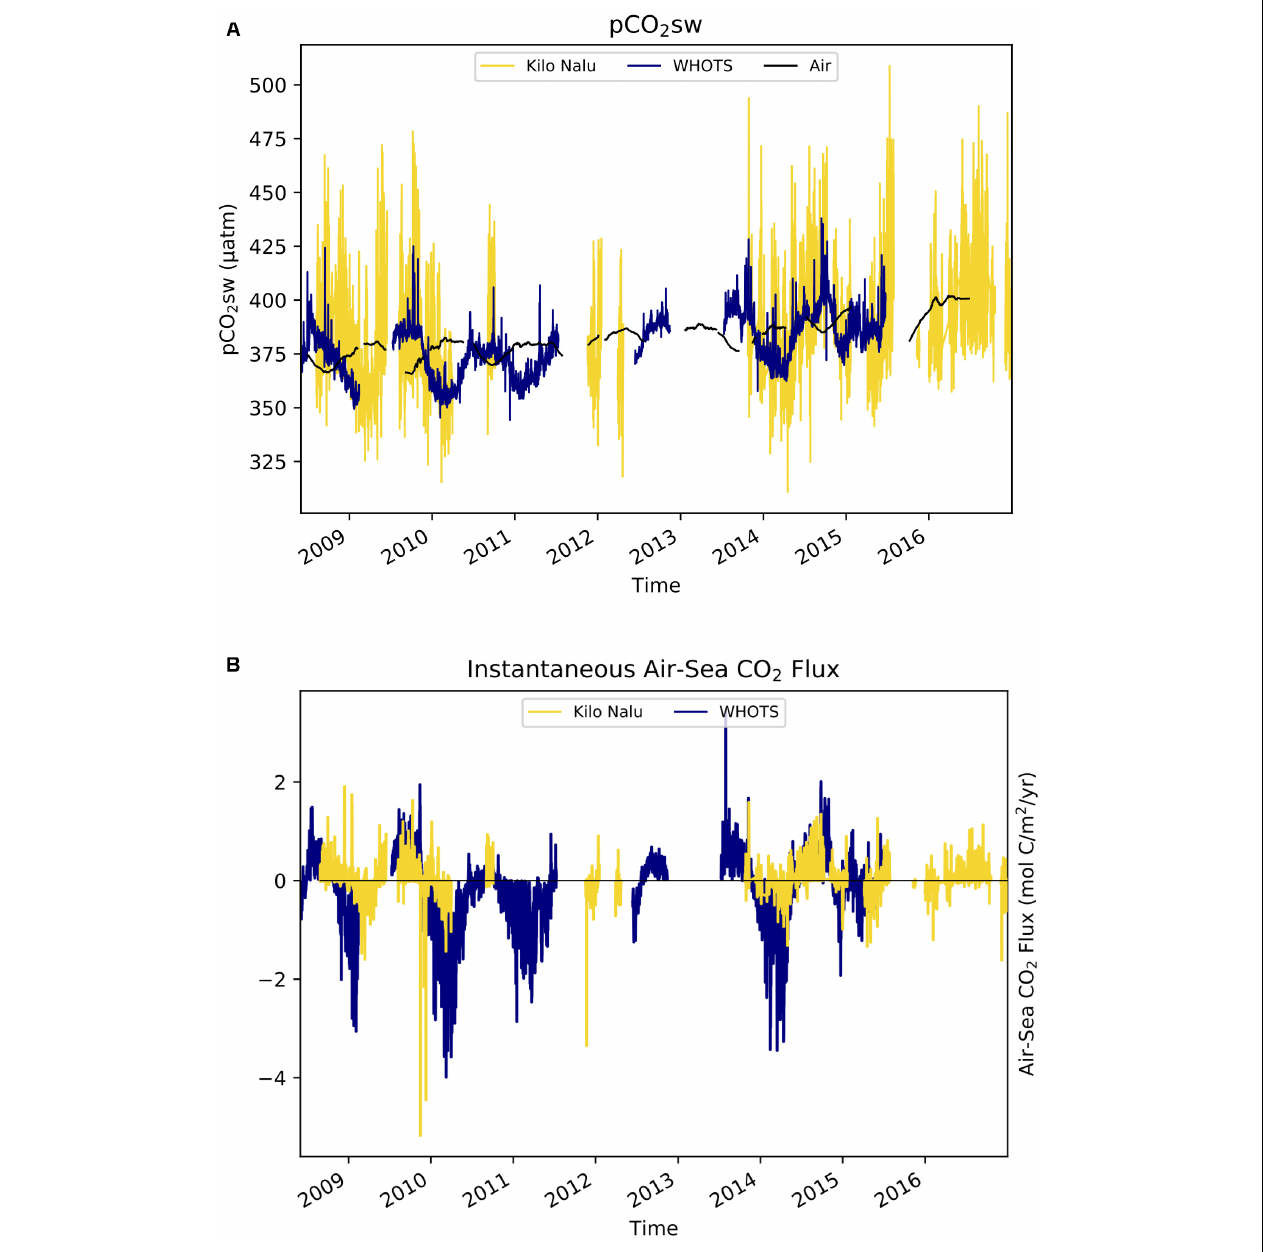
FIGURE 7 | Time-series of p CO 2 sw and air-sea CO 2 fluxes at Kilo Nalu and WHOTS from June 2008 through December 2016. This figure is similar to Figures 2A , 4 , but plotted on a narrower y -axis range to highlight the differences in variability at Kilo Nalu and WHOTS. (A) In situ (3-hourly) p CO 2 sw in units of µ atm. (B) Air-sea CO 2 fluxes in units of mol C m − 2 yr − 1 where positive values indicate a source of CO 2 to the